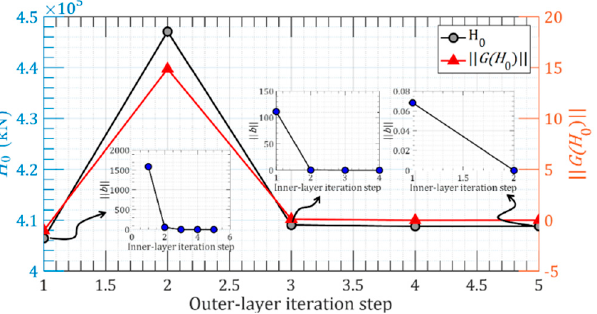
Figure 11. Outer-layer and inner-layer iteration results for 3D spatial main cables in Case 2.